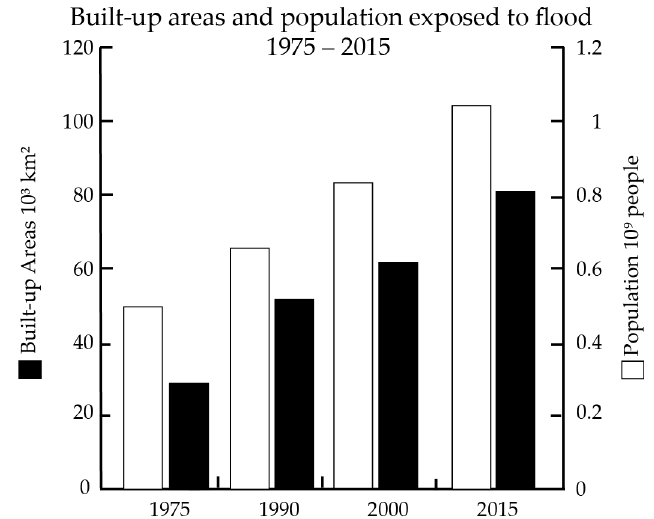
Figure 8. Built-up area and population in areas prone to flood based on a probabilistic hazard assessment from floods with return period of 100 years.